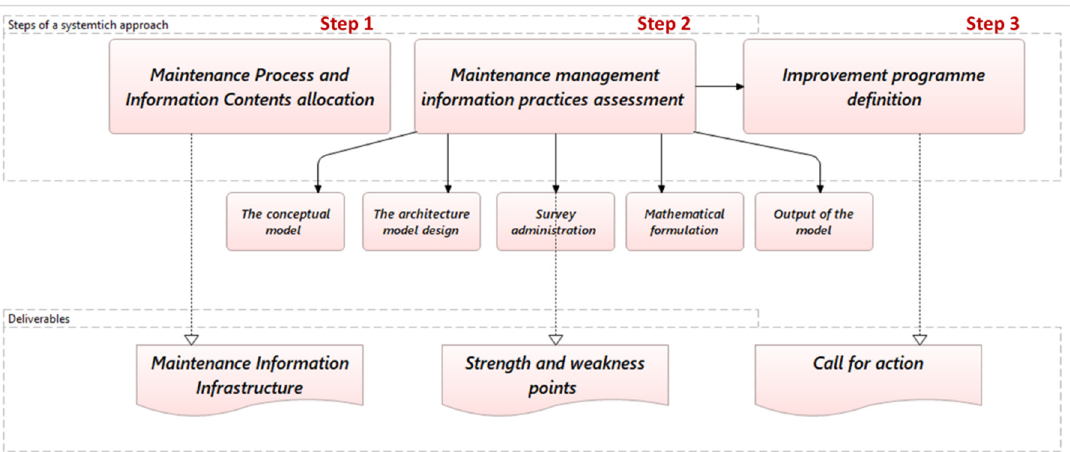
Figure 1. The M 3 AIN4SME model.